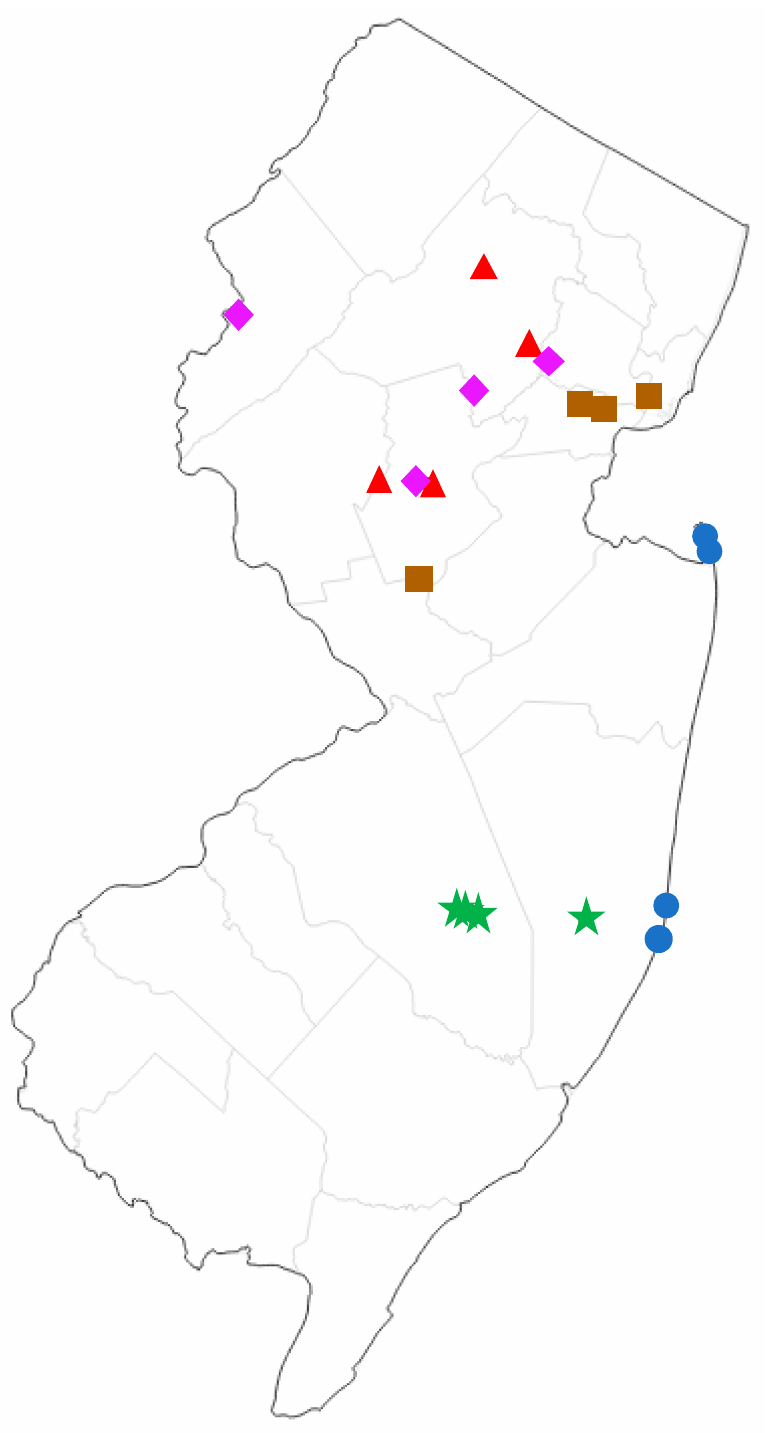
Figure 1. Map of sampling sites in New Jersey, USA. Green stars = pine barrens, blue circles = maritime forest, purple diamonds = palustrine deciduous forest, red triangles = upland deciduous forest, brown squares = ruderal (highly disturbed).